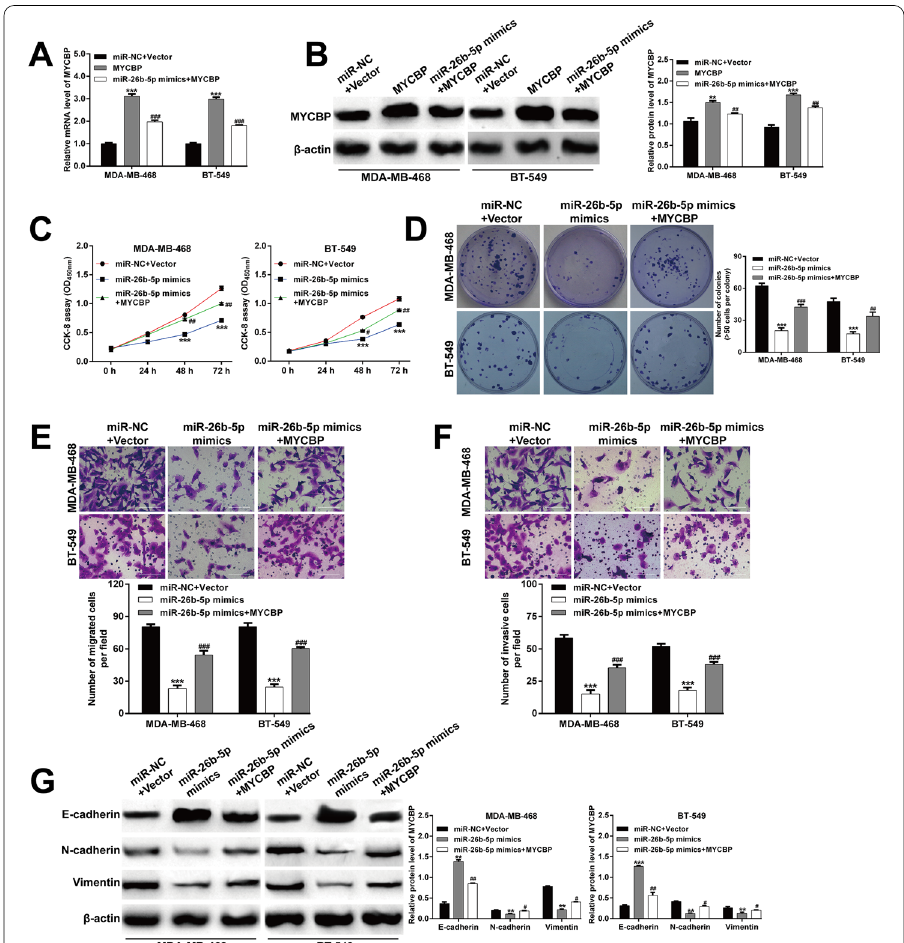
Fig. 5 MYCBP overexpression counteracted the suppressive effect of miR-26b-5p on TNBC cell behaviors. MDA-MB-468 and BT-549 cells were co-transfected with MYCBP overexpressing plasmid and miR-26b-5p mimics. The expression levels of MYCBP mRNA ( A ) and protein ( B ) in MDA-MB-468 and BT-549 cells after indicated transfection were determined by PCR and western blot assays. C Cell viability was determined using CCK-8 assay in MDA-MB-468 and BT-549 cells after indicated transfection. D The number of colonies in MDA-MB-468 and BT-549 cells after indicated transfection. Cell migration ( E ) and invasion ( F ) were assessed by transwell assay in MDA-MB-468 and BT-549 cells after indicated transfection. Magnification, 200; scale × bar, 100 μm; data are shown as mean SD (n 3). *** p < 0.001 compared with miR-NC Vector group; ± = + # p < 0.05, ## p < 0.01, ### p < 0.001 compared with MYCBP or miR-26b-5p mimics; G The protein levels of E-cadherin, N-cadherin and vimentin were measured by western blot analysis in MDA-MB-468 and BT-549 cells after indicated